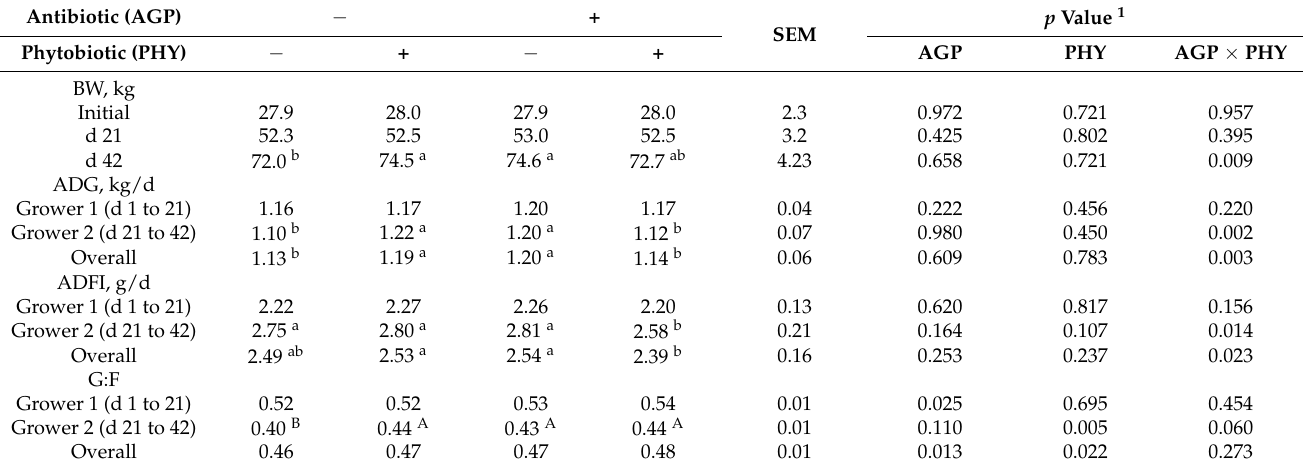
Table 4. Growth performance of growing pigs fed diets supplemented with phytobiotics and antibi- otics as growth promoters (Exp.